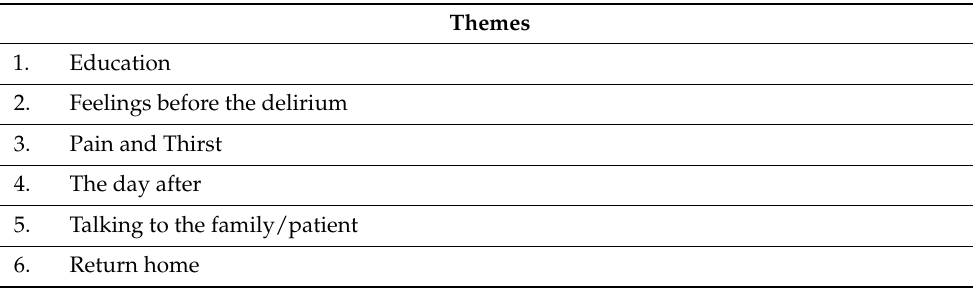
Table 2. Themes identified during the